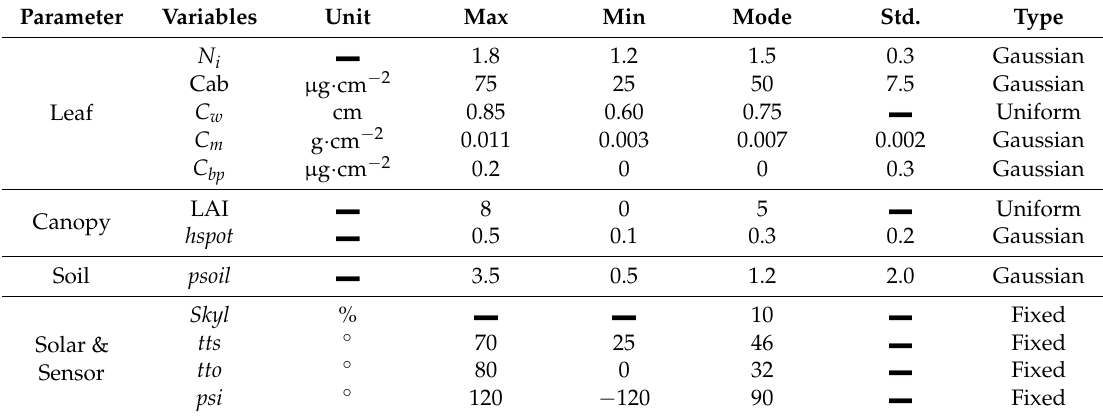
Table 5. Ranges and distribution of the leaf, canopy, soil, solar, and sensor parameters in the PROSAIL